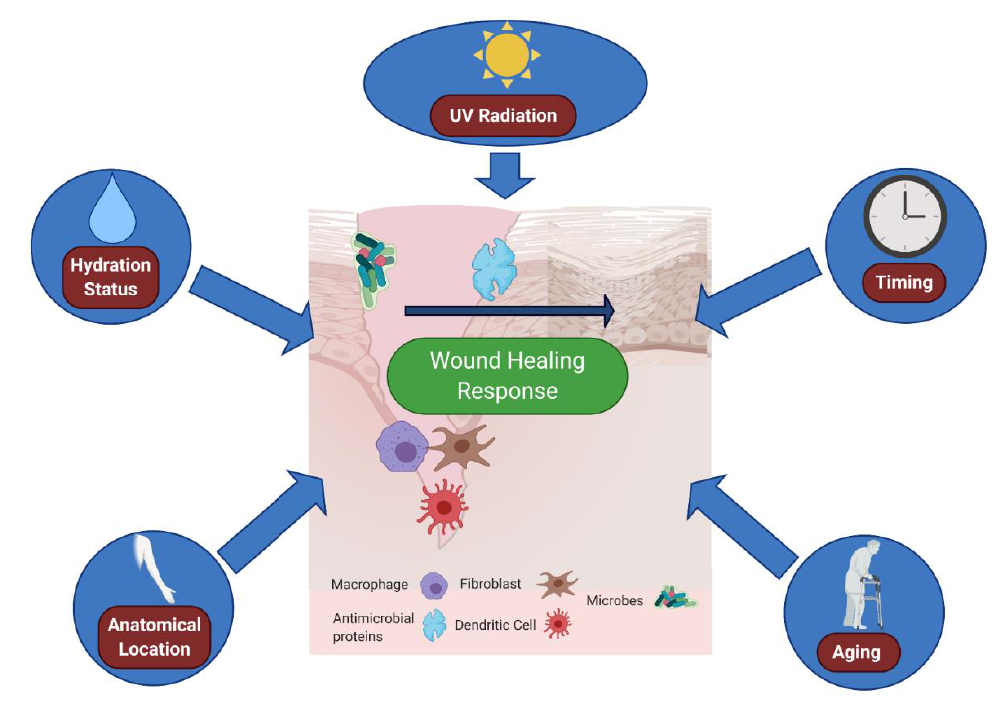
Figure 2. Variables affecting the cutaneous immune microenvironment of wounds. Environmental impacts, such as skin moisture, ultraviolet (UV) exposure, timing of wounding and location of the wound, can all modulate immune responses to barrier disruption. Skin moisture levels can alter immune expression of antimicrobial proteins [76] as well as immune cell infiltration [79]. UV exposure can promote wound closure [84], as well as interferon signature [83]. Time of day can alter fibroblast activity in the wound [85], as well as immune cell trafficking [86]. The location of the wound on the body matters as well, as various immune cells differ in proportion throughout the body dependent on the location [80]. Finally, aging plays a major role in the microenvironment of wounds; aged skin is deficient in neutrophil and macrophage recruitment [87] and is also slower to re-epithelialize [88]. Figure created using Biorender.